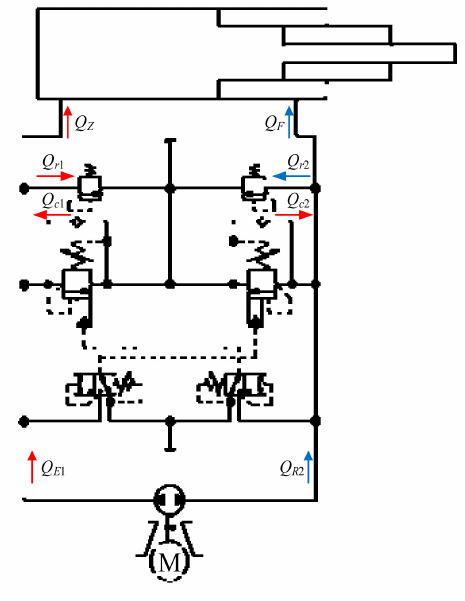
Figure 7. Schematic diagram of hydraulic